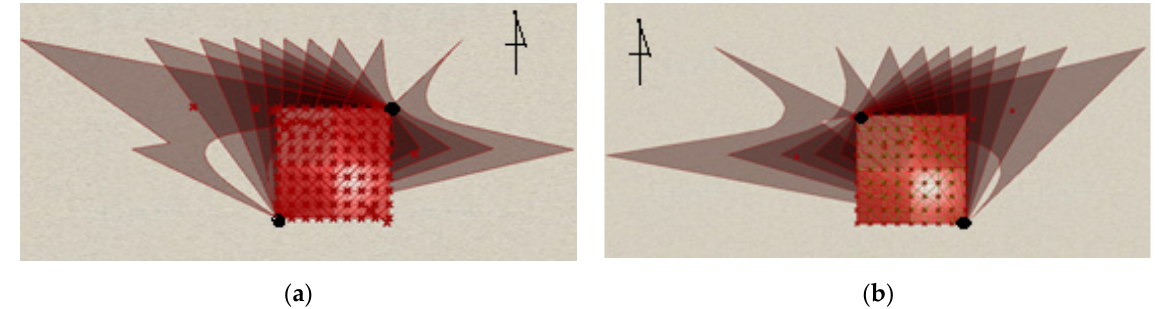
Figure 10. The border of the shadow cast depending on the location of ground supports: ( a ) a right ground support on the north side; ( b ) a left ground support on the north